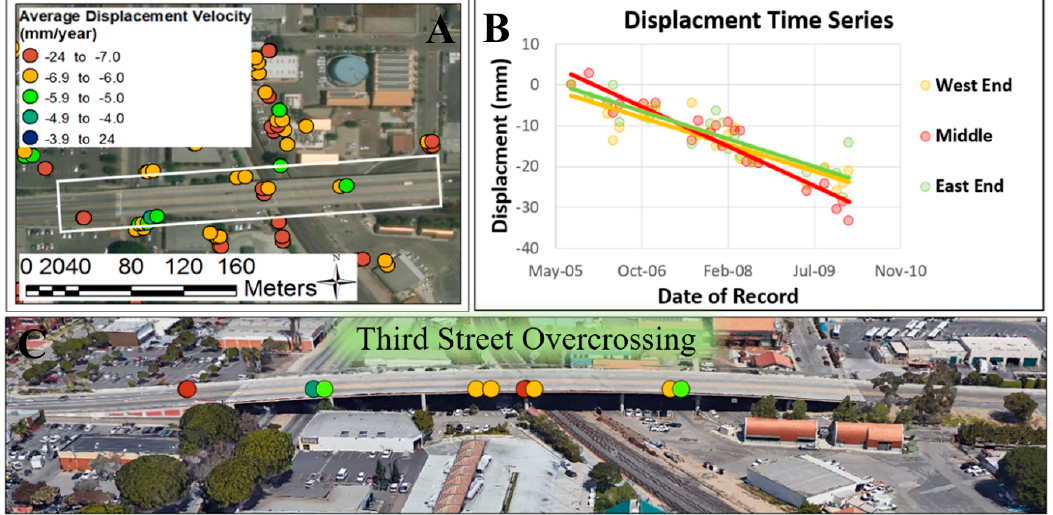
Figure 6. Third street overcrossing displacement model. ( A ) Aerial view of the bridge; ( B ) Displacement time series; ( C ) Elevation view of the bridge. Source: Images for Figure 6A,C were obtained from Google Earth [48].